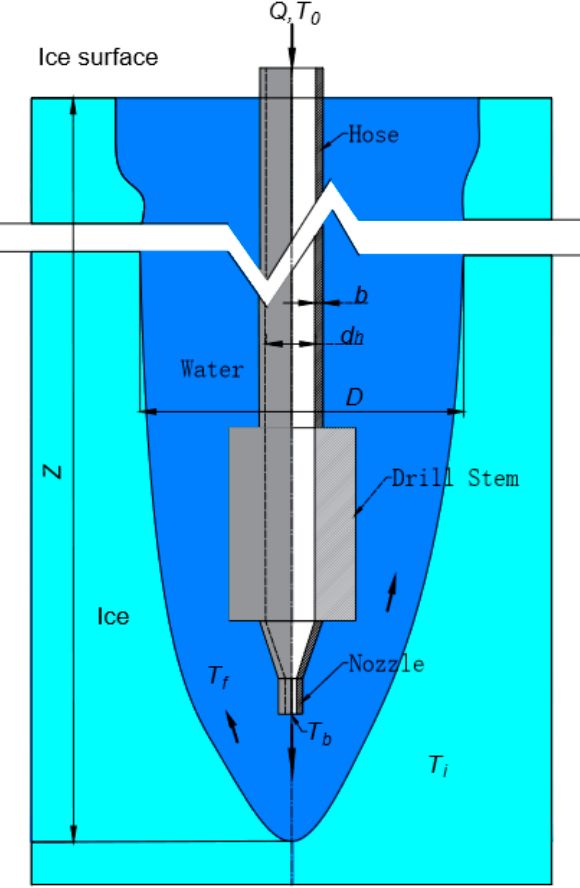
Figure 3. Schematic diagram of hot water drilling process ( Q is the mass flow rate of hot water, kg s − 1 ; Z is the borehole depth, m; D is the mean diameter of borehole, m; T 0 is the initial temperature of water, ° C; T ° C; T i is the ice temperature, f is the final temperature of the mixture of hot water and melted ice, ° C; T b is the bottom temperature of drilling water that sprays out of the nozzle, ° C; d h and b are the hose diameter and wall thickness, respectively, m)